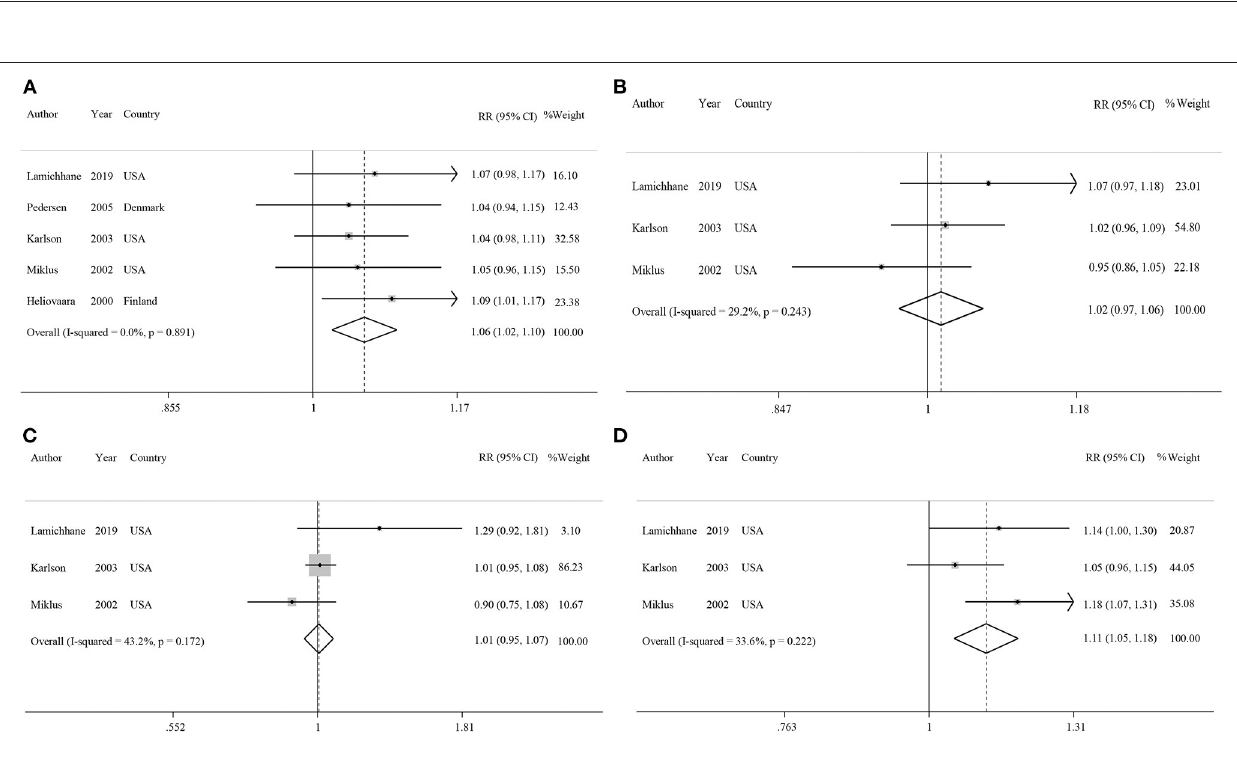
Frontiers in Nutrition |